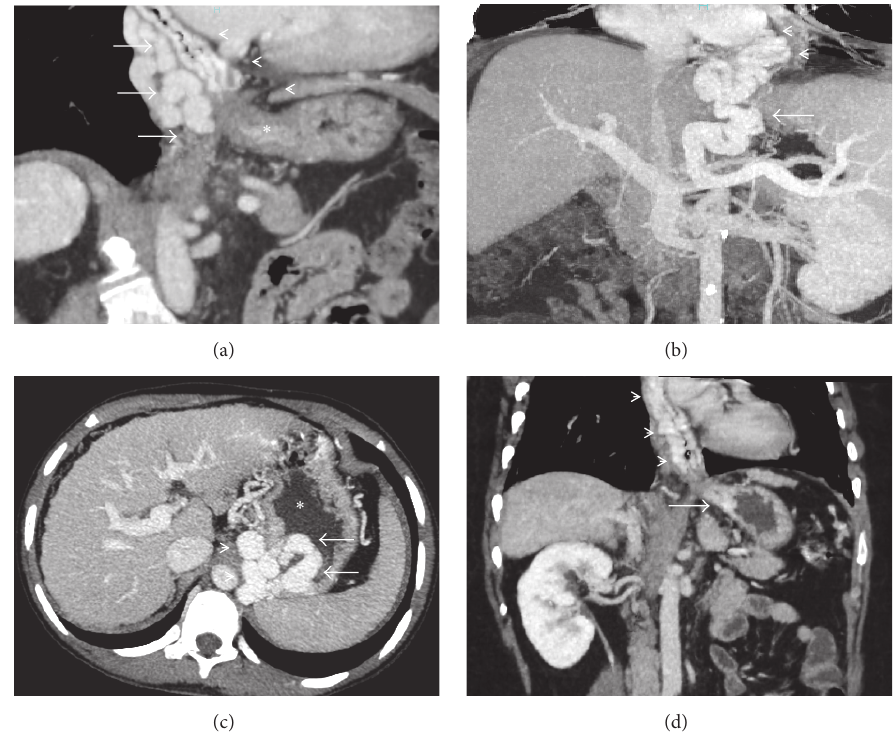
Figure 1: (a) Coronal-oblique MIP image demonstrating multiple collaterals in the esophagus (arrowheads) as well as paraesophageal region (arrow). Asterisk denotes the gastroesophageal junction; (b) coronal-oblique maximum-intensity-projection (MIP) CECT image showing a dilated left gastric vein (arrow) which is serving as an afferent for multiple paraesophageal collaterals (arrowheads); (c) axial MIP image showing multiple gastric fundal collaterals (arrows) being drained by a tortuous gastrorenal shunt (arrowheads) into the left renal vein (not shown). Asterisk denotes the gastric lumen. This corresponds to IGV-1 in Sarin classification of gastric varices; (d) coronal MIP image showing multiple esophageal collaterals (arrowheads) continuing along the cardia to form collaterals in the lesser curvature of stomach. This corresponds to GOV-1 in Sarin classification of gastric